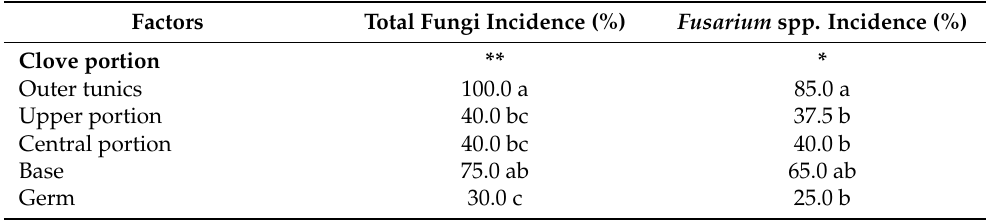
Table 7. Analysis of variance of total fungal incidence (%) and Fusarium spp. incidence (%) in the 5 portions of the clove analyzed (outer tunics, base, germ, upper and central portion of the clove) at the end of the first trial with microscopy techniques. Different letters indicate significant differences according to Tukey’s test ( p <